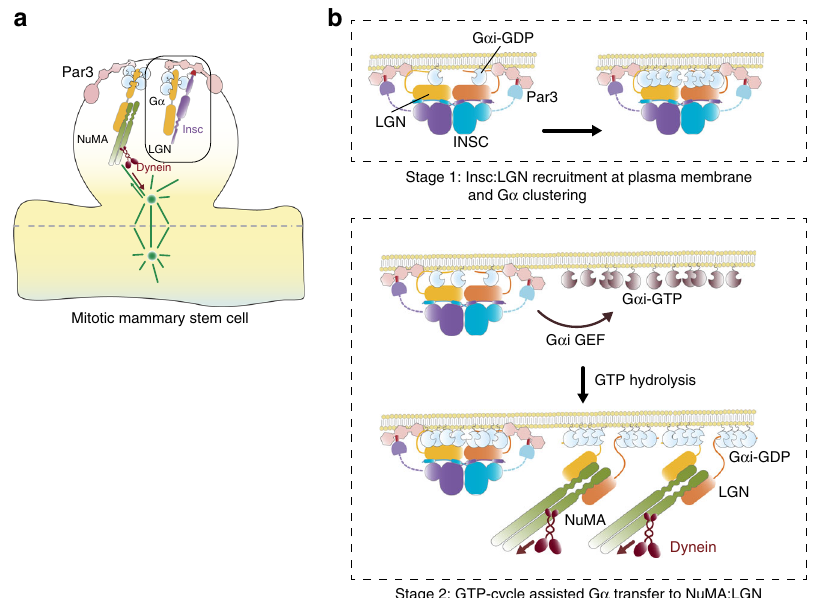
Fig. 6 Model of the role of Insc:LGN complex in asymmetric divisions. a Schematic diagram depicting the organization of cortical domains and mitotic spindle motors in murine mitotic mammary stem cells. b Schematic representation of the asymmetric function of Insc:LGN tetramers supported by our study. Initally, Insc:LGN complexes are recruited at the apical membrane by direct binding of LGN to G α i-GDP molecules, and by association of Insc with Par3. Cooperative binding to LGN-GoLoco motifs favors G α i-GDP apical clustering. Later, a G α i GTP-cycle, likely catalyzed by a GEF such as Ric-8A, dissociates G α i from Insc:LGN, generating a localized pool of G α i-GTP molecules, which upon GTP hydrolysis recruits LGN:NuMA:Dynein complexes at the apical site. According to this model, stable Insc:LGN assemblies couple asymmetric fate speci fi cation with apico-basal spindle orientation by G α